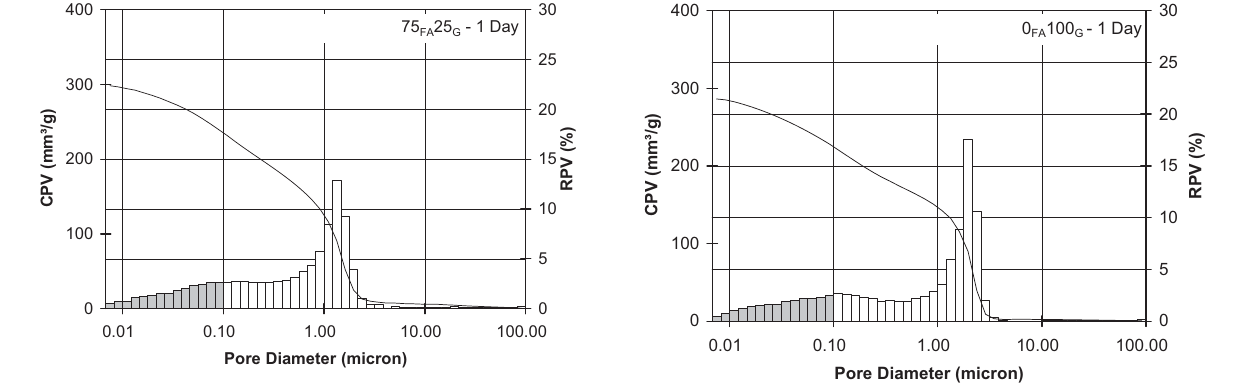
Fig. 9. Pore size distribution of paste P8